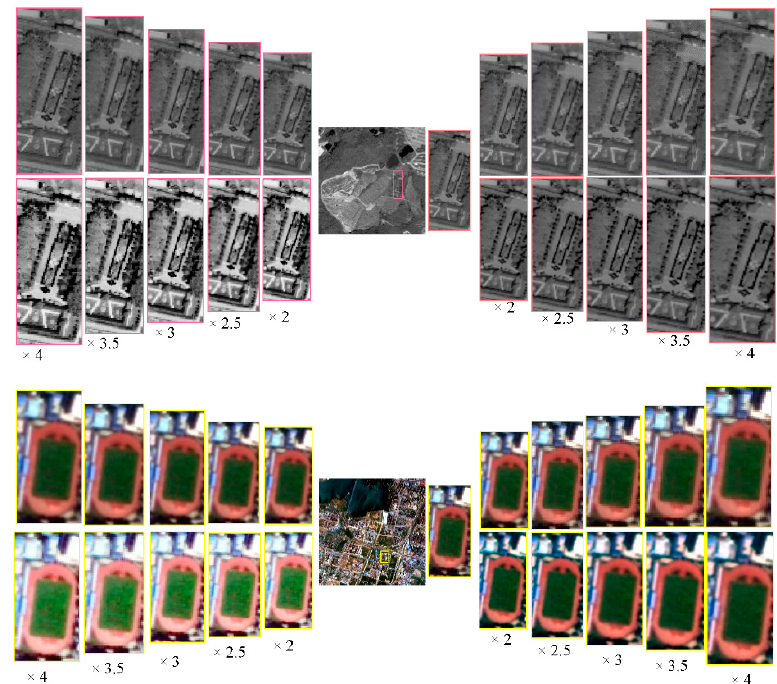
Figure 8. Different up-scaling factor SRR results. ( left top ) The result based on IBP; ( left bottom ) the result based on HE; ( right top ) the result based on Bicubic; ( right bottom ) the result based on MMSDB-SR.